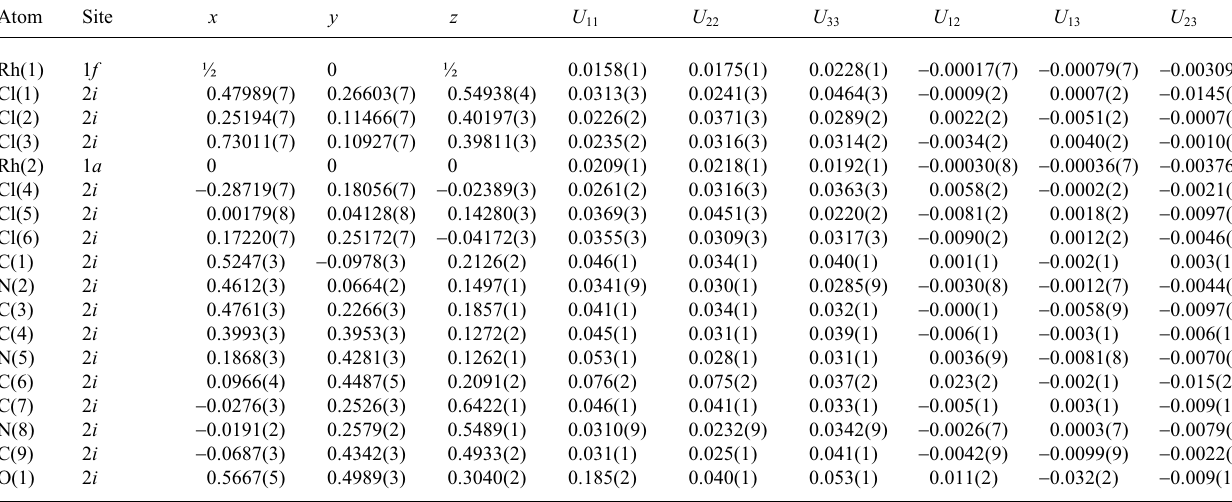
Table 3. Atomic coordinates and displacement parameters (in Å 2 )